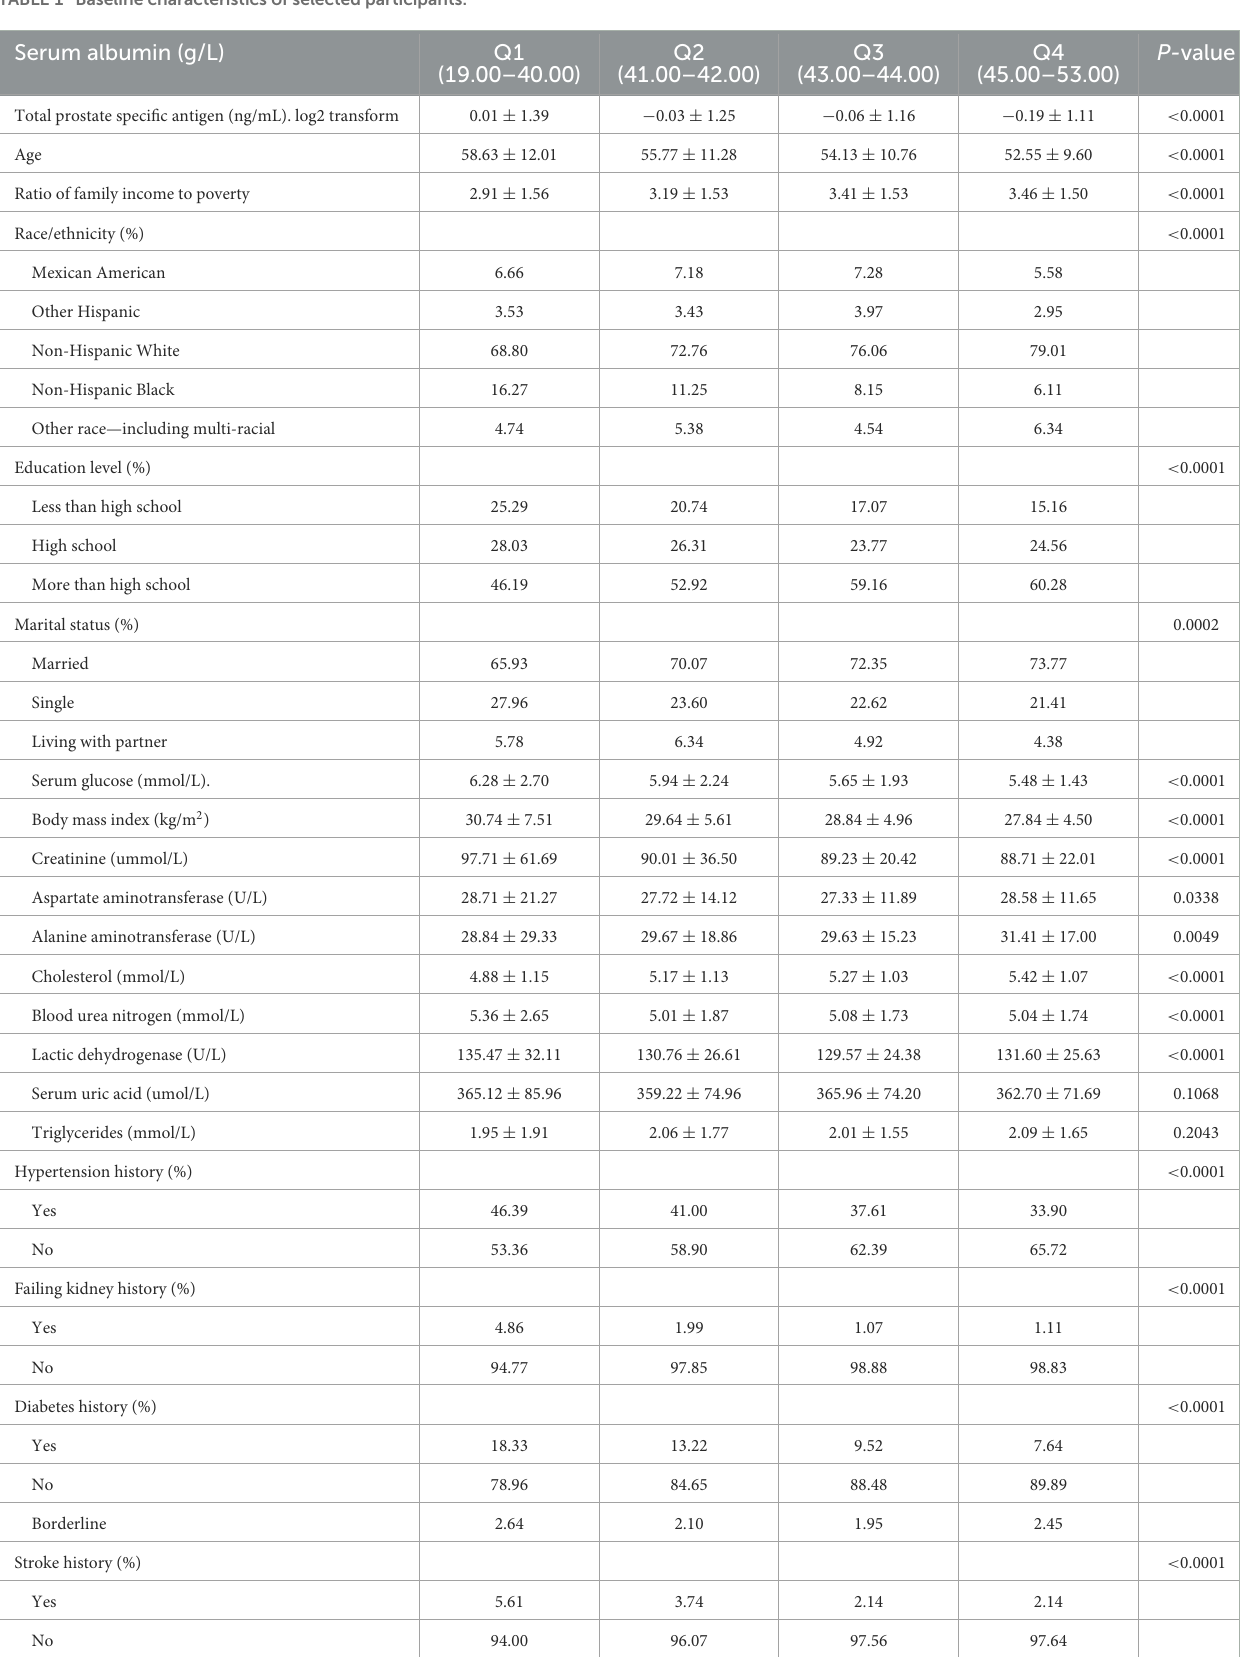
TABLE 1 Baseline characteristics of selected participants. Serum albumin